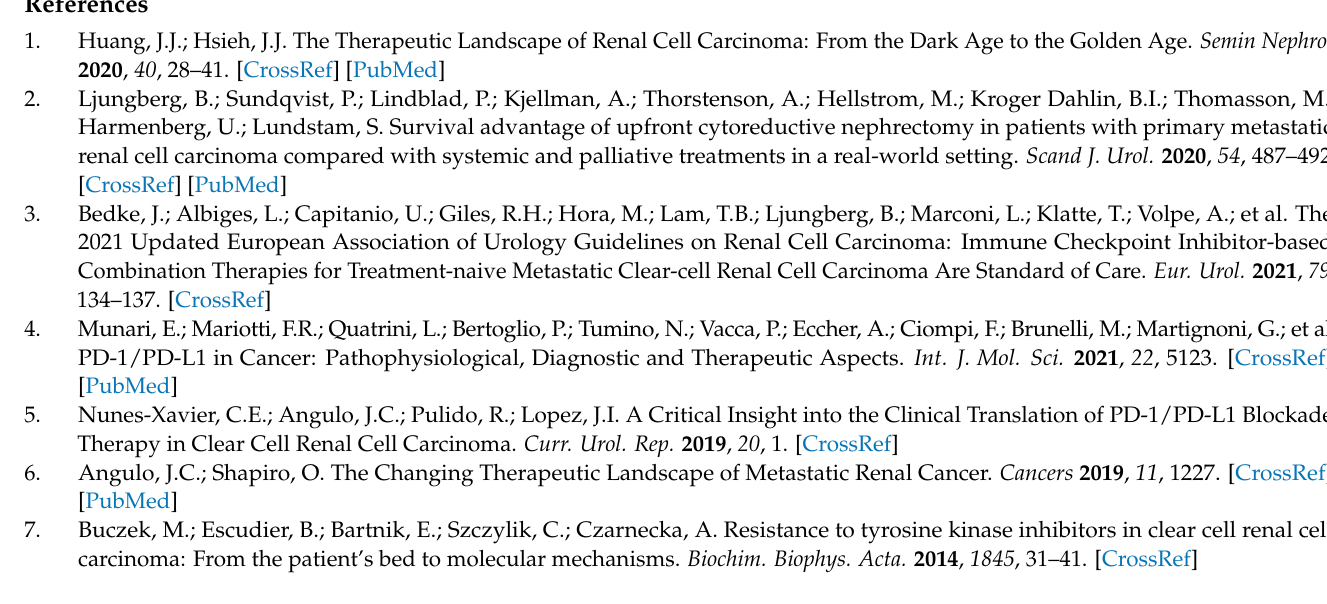
Figure S2: Proliferation of HEK293, Caki-1, 786-O, and A-498 cells upon treatment with different doses of tyrosine kinase inhibitors or with mTOR